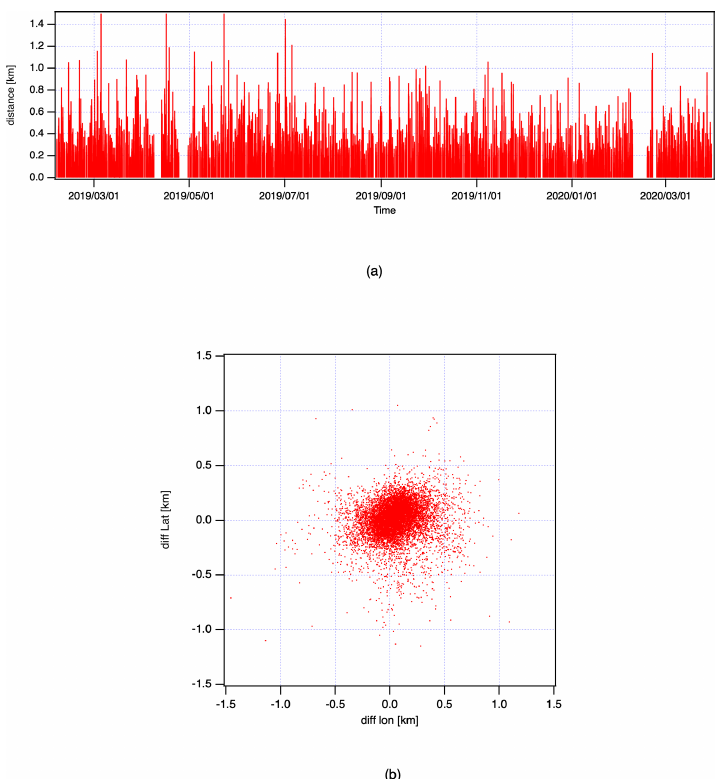
Figure 16. Geometric difference between the processed pointing location and the ground control position using onboard camera images. (a) Time series since launch. (b) Scatter plot in latitude and